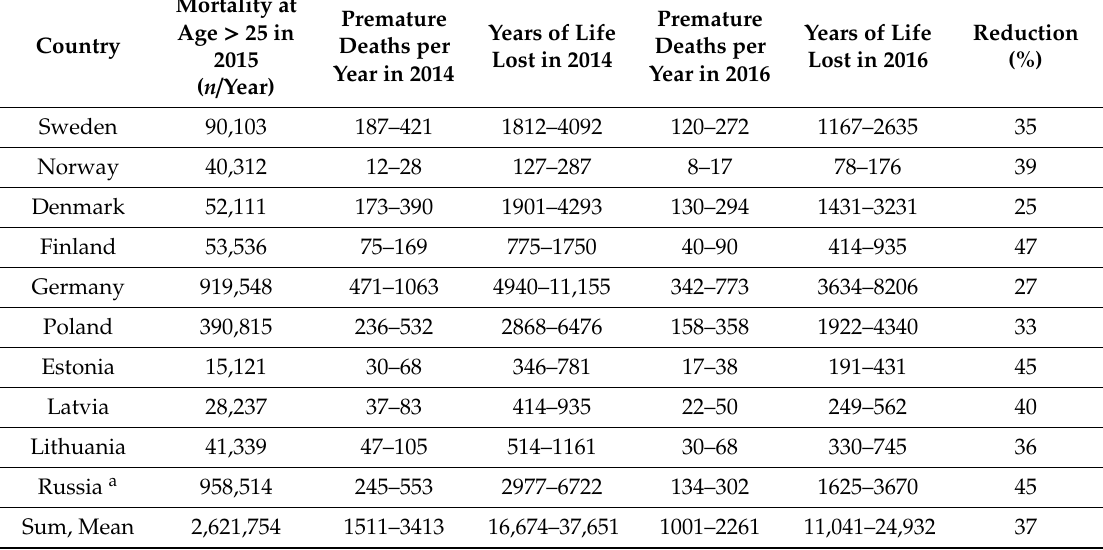
Table 2. Estimated number of premature deaths (natural mortality), due to PM 2.5 emissions from Baltic shipping in 2014 and 2016 according to two alternative exposure response functions. The left one of the two numbers given refers to the ER function suggested in the HRAPIE report [21] and the right one the ER function found in the ESCAPE study